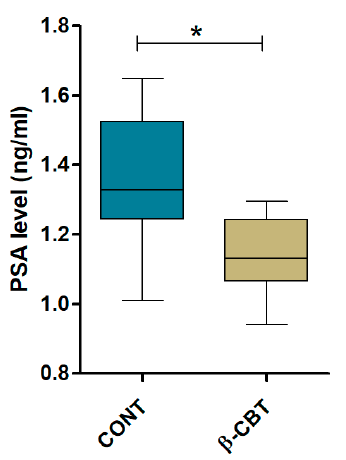
Figure 7. Effect of daily oral 15 mg/kg β -CBT treatments on PSA plasma level in mice xenografted with PC-3M-Luc cells at the study end. Data represent median, minimum and maximum of vehicle- treated control group and β -CBT-treated group. * indicates statistical significance at p < 0.05.